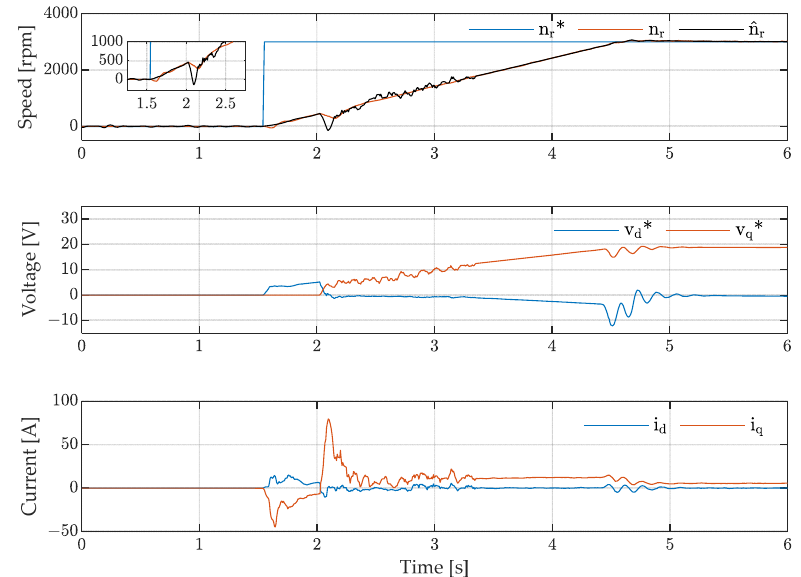
Figure 27. The motor start ‐ up in stable V / f control with CPF and transition to the sensorless FOC with Luenberger ‐ type back ‐ EMF observer: speed, dq voltages, dq currents.